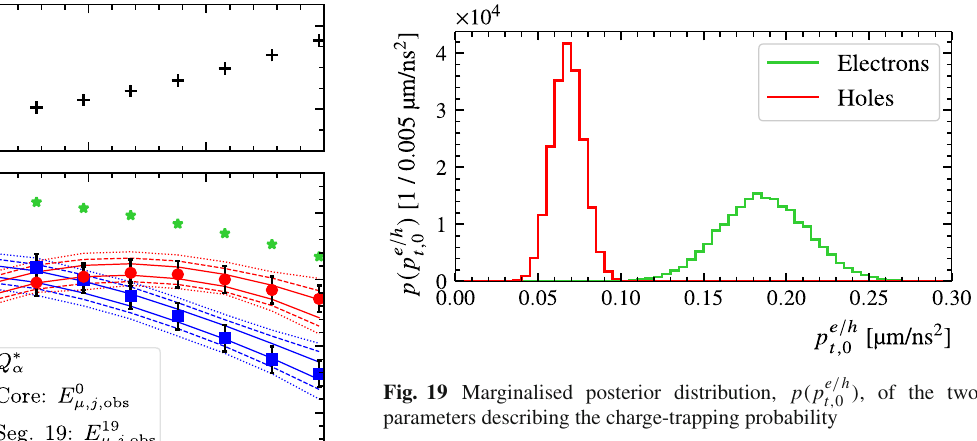
Fig. 19 Marginalised posterior distribution, p ( p e parameters describing the charge-trapping